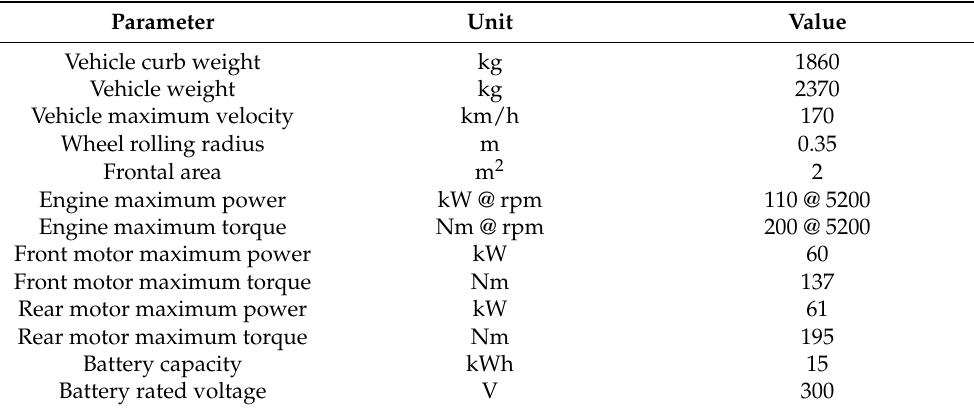
Figure 1. The schematic of the 4DW PHEV configuration. Table 1. Vehicle and dynamic component parameters in the 4DW PHEV.